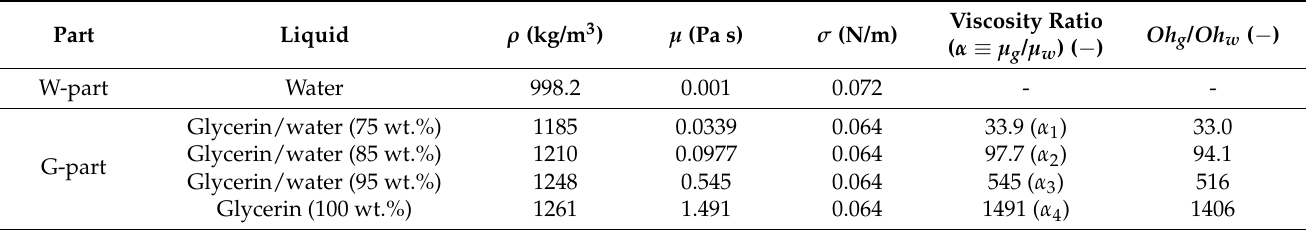
Table 1. Liquid properties of two fluidics parts. Reprinted with permission from [22]. Copyright 2019 American Chemical Society. Reprinted with permission from [28]. Copyright 2022 AIP Publishing.